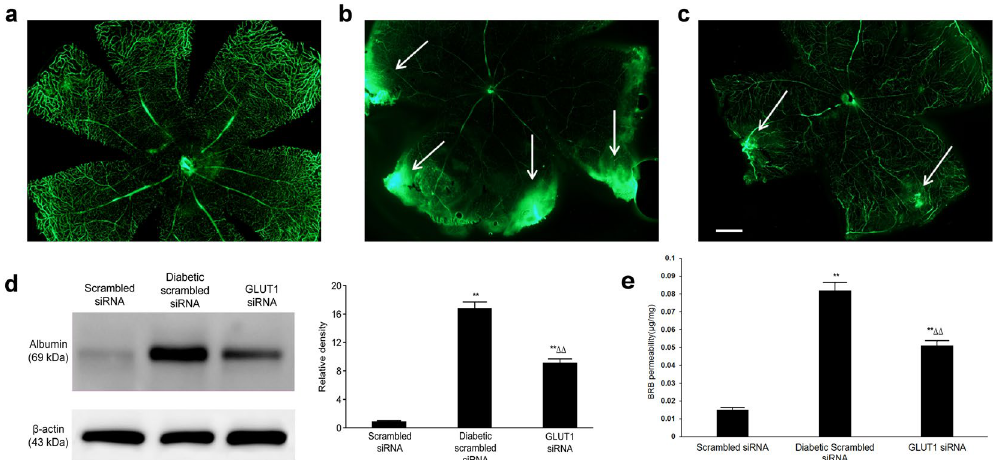
Figure 5. Comparison of leakage of the inner blood–retinal barrier among the three groups ( a ) scrambled siRNA group; ( b ) diabetic scrambled siRNA group; ( c ) GLUT1 siRNA group, scale bar represents 200 µ m, fluorescence microscope × 400; white arrows indicate fluorescence leakage regions; ( d ) Expression of retinal albumin in mice of the three groups, ( e ) BRB permeability assay using Evans blue dye in mice of the three groups, ** P < 0.01 vs. scrambled siRNA group, ΔΔ P < 0.01 vs. diabetic scrambled siRNA group, n = 6, x ± S. Full-length blot is presented in Supplementary Figure